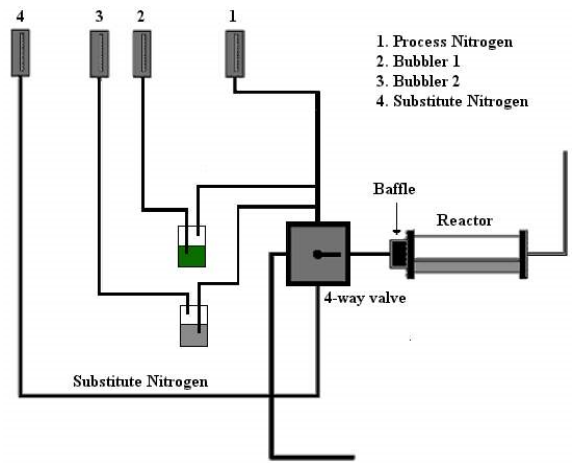
Figure 1. A schematic presentation of the atmospheric pressure chemical vapor deposition (APCVD)